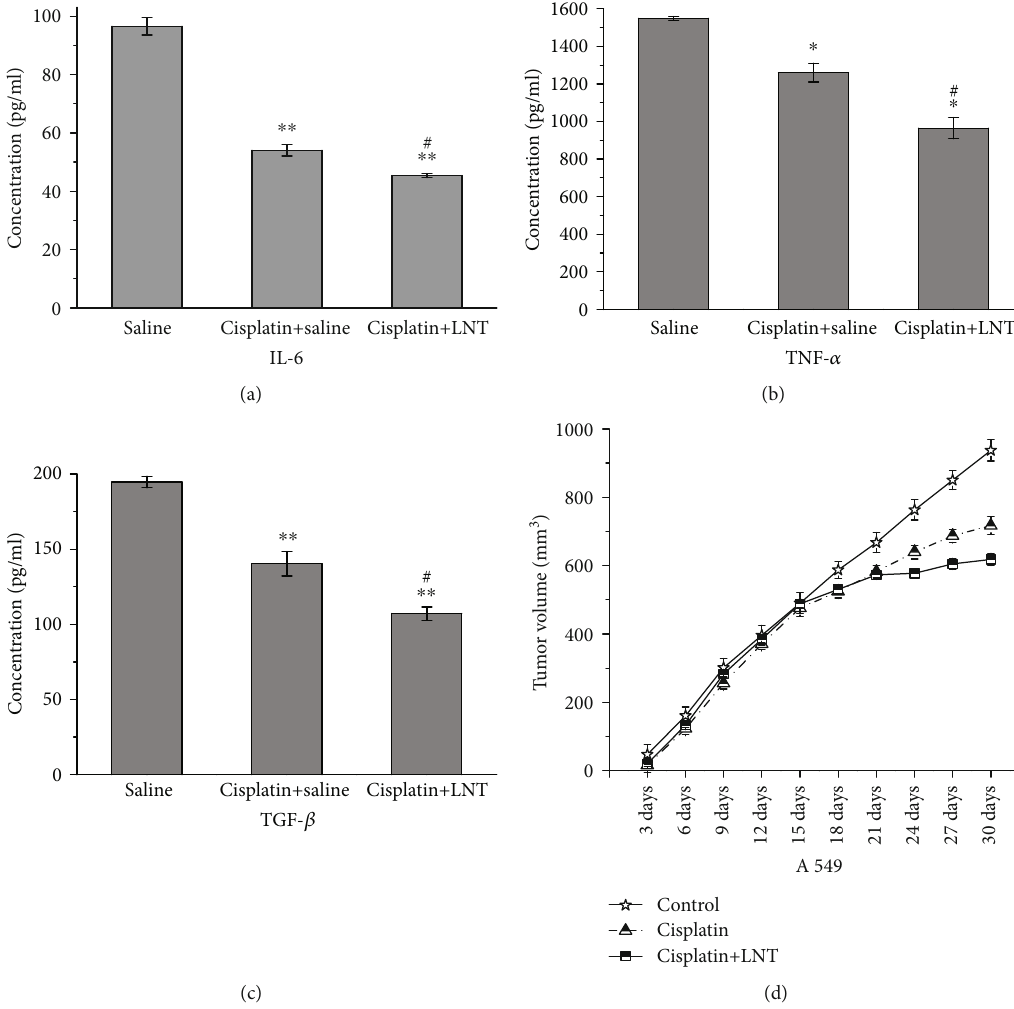
Figure 5: Enhanced inhibitory e ff ect of cisplatin on expressions of IL-6, TNF- α , and TGF- β and tumor growth in mice bearing human non- small cell lung cancer xenograft by combination therapy of lentinan and cisplatin. (a – c) It is enhanced by the combined treatment of lentinan and cisplatin that the expression of IL-6 (a), TNF- α (b), and TGF- β (c) on the serum of mice bearing non-small cell lung cancer induced by cisplatin. (d) It is enhanced by the combined treatment of lentinan and cisplatin that the inhibition of tumor growth of mice bearing non- small cell lung cancer by cisplatin. ∗ P < 0 : 05 , ∗∗ P < 0 : 01 , signi fi cantly di ff erent from the saline group. # P < 0 : 05 , ## P < 0 : 01 , signi fi cantly di ff erent from the cisplatin+saline group.